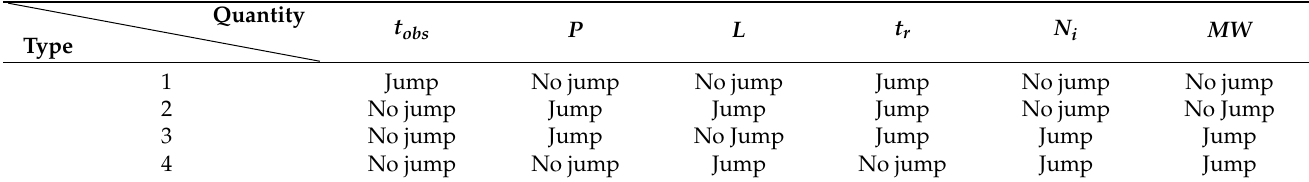
Table 1. Quantity states according to receiver clock jumps of different